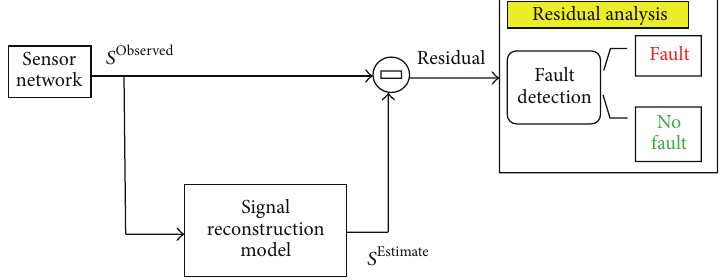
Figure 1: Integrated sensor estimation and fault detection